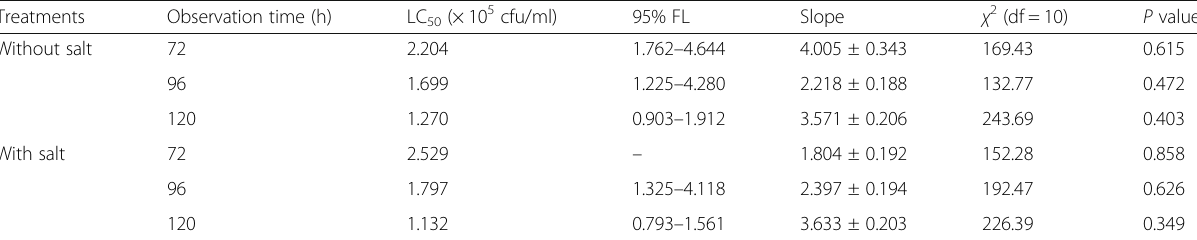
Table 3 Median lethal concentration (LC 50 ) values of Bacillus thuringiensis strain isolated from soil bioassayed against the third-instar larvae of Helicoverpa armigera Hübner Treatments